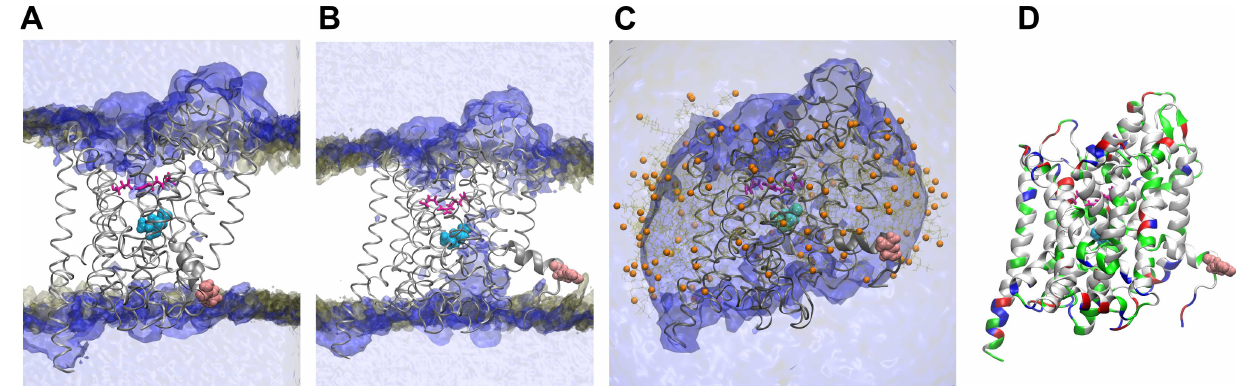
Fig 3. Water density in LeuT. Water (blue) and phosphate (of POPC lipids) density (brown) were averaged over the 200 ns of run 1. The starting structure of LeuT is shown, the substrate leucine (cyan), the salt bridge of the outer vestibule (magenta), R11 (pink) and the O1 atoms of BOG (orange) are highlighted. (A) Water penetratesuntil the salt bridge of the extracellular gate (R30 and D404) in the outward- occludedstate. (B) Opening of the inner vestibule allowedwater to reach the substrate of the inward-openLeuT. (C) Similar water penetrationwas observed in the micelle embeddedinward-openLeuT. ( D ) The physico-chemical properties of all residues are mapped onto the structure of the inward-facing structure using a color code: non-polar(white), polar (green), positively charged (blue), negativelycharged